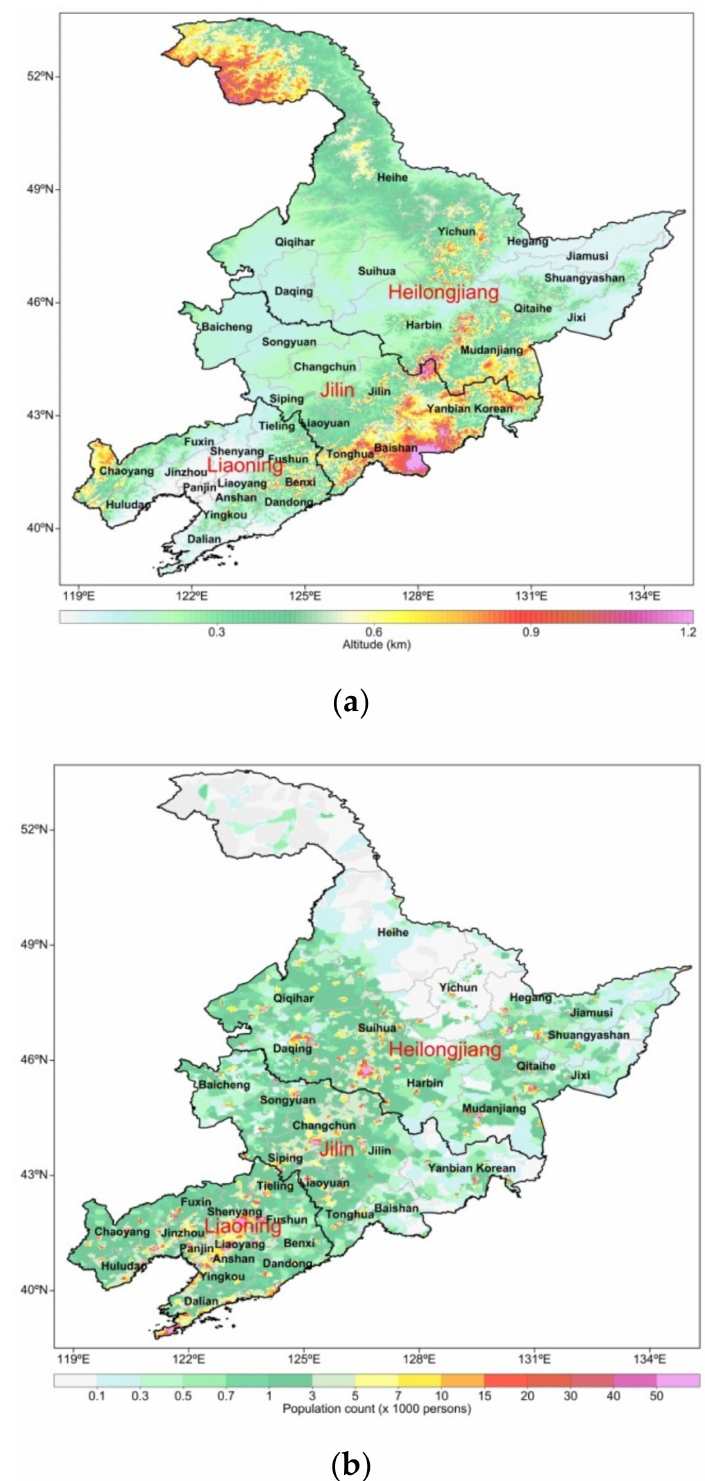
Figure 1. ( a ) Geography and city distribution and ( b ) population density in